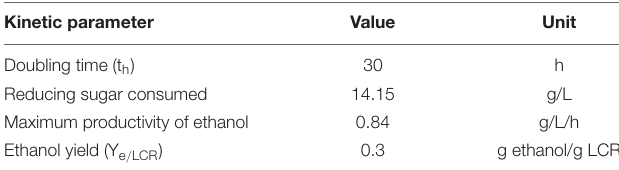
TABLE 3 | Kinetic values by yeast for fermentative ethanol production from LCR hydrolyzate with the enzyme volume of 25 U/g